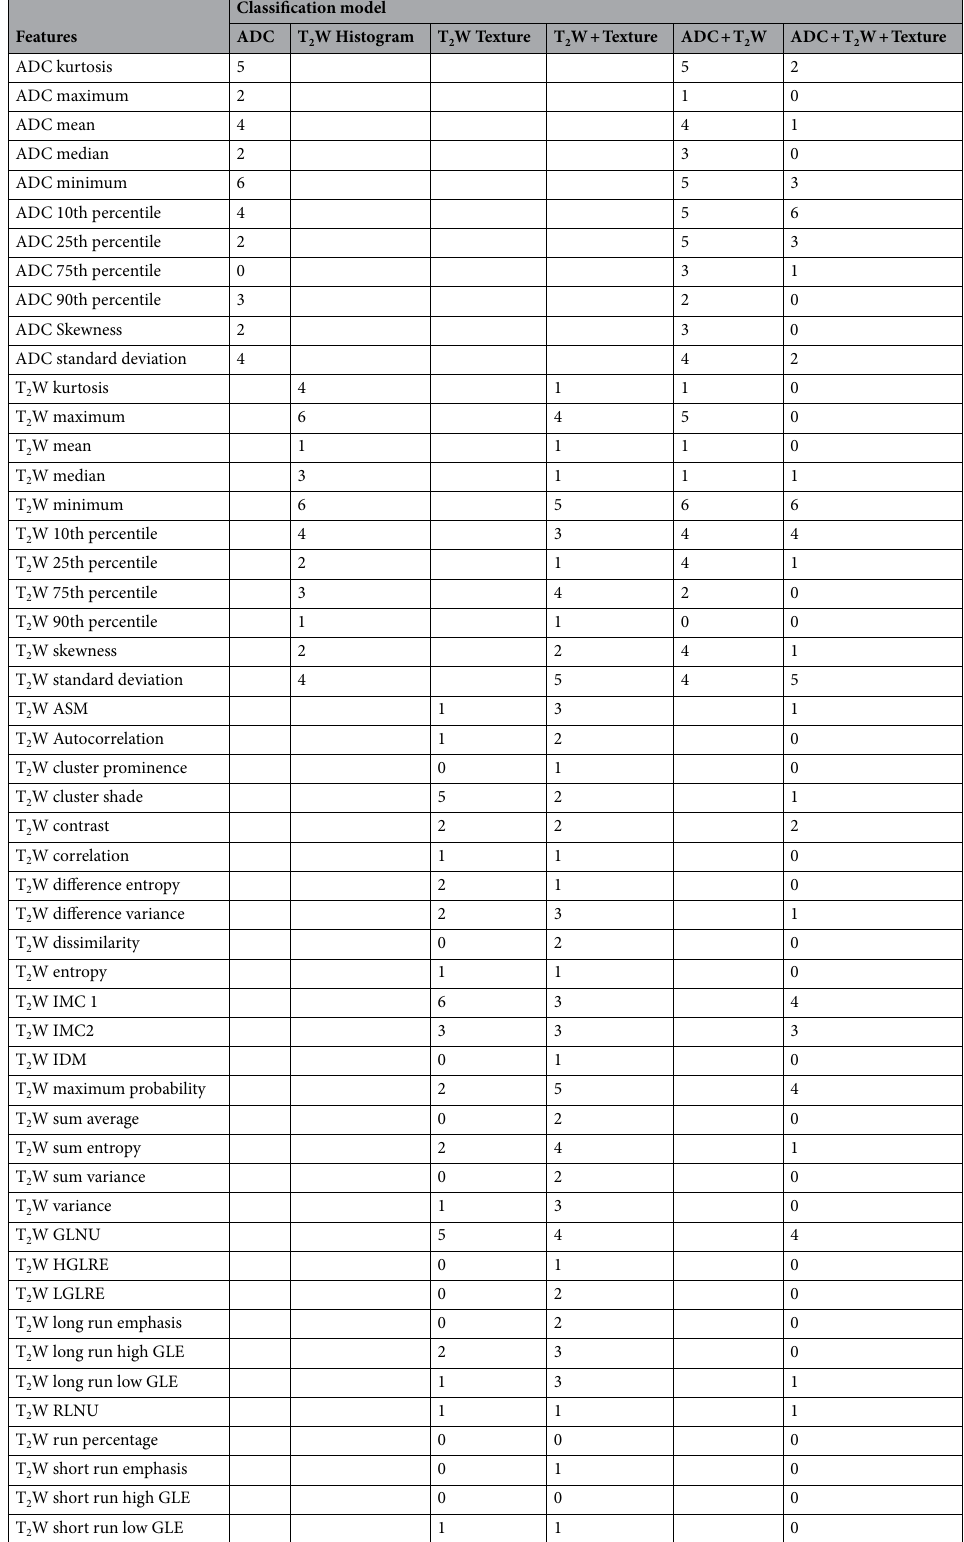
Table 4. Frequency of feature selection for SVM classification of low-(grade group 1) vs. intermediate/ high-(grade group ≥ 2) aggressive prostate cancers across six institutions. SVM support vector machine, ADC apparent diffusion coefficient, T 2 W T 2 -weighted, ASM angular second moment, IMC information measure of correlation, IDM inverse difference moment, GLNU grey level non-uniformity, HGLRE high grey level run emphasis, LGLRE low grey level run emphasis, GLE grey level emphasis, RLNU run length